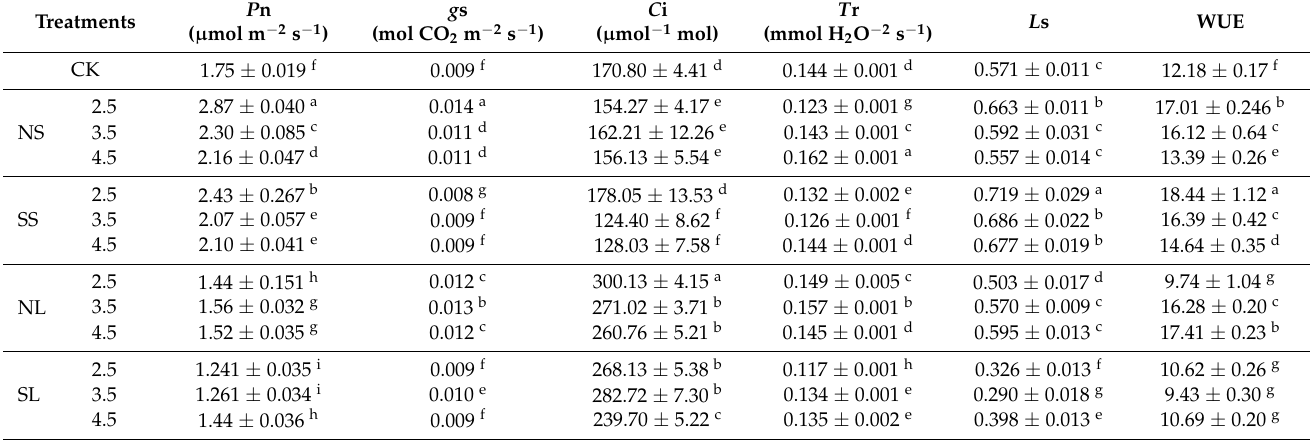
Table 3. Effect of different forms of acid stress on gas exchange index of A. catalpifolium. The treatments: CK, NS, NL, SS and SL are defined as control, nitric-balanced acid applied to soil, nitric-balanced acid applied to leaves, sulfuric-dominated acid applied to soil and sulfuric-dominated acid applied to leaves, respectively. Values are the average ± standard deviation (n = 10). Different superscript letters in each column indicate a significant difference among different acid treatments ( p < 0.05).